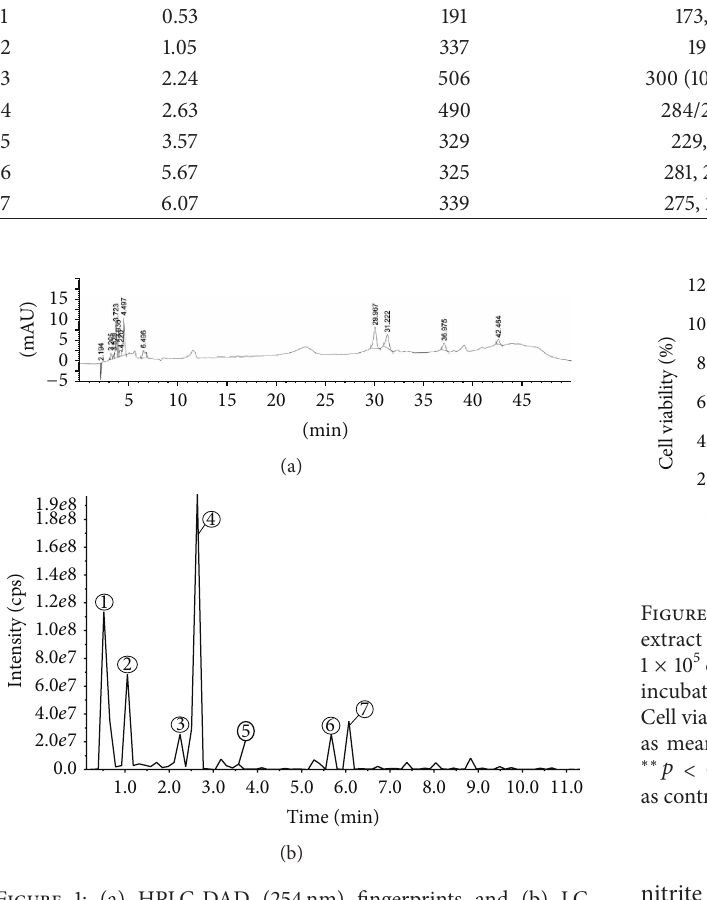
Figure 1: (a) HPLC-DAD (254 nm) fingerprints and (b) LC- MS/MS (254 nm) chromatogram of M. oleifera hydroethanolic flower extract.